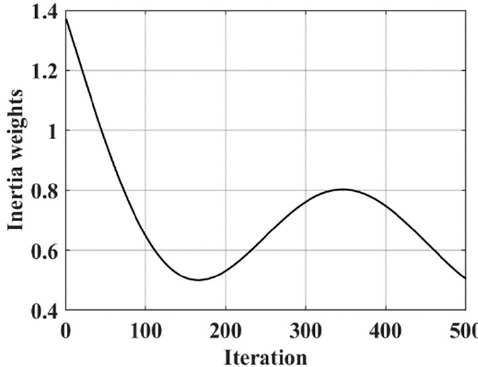
Figure 3. Curve of inertia weight change.